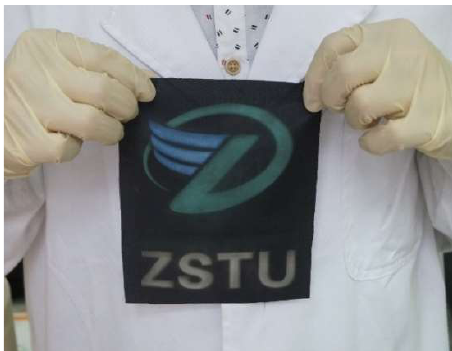
Figure 4. Structural color pattern of our university logo on polyester fabric.